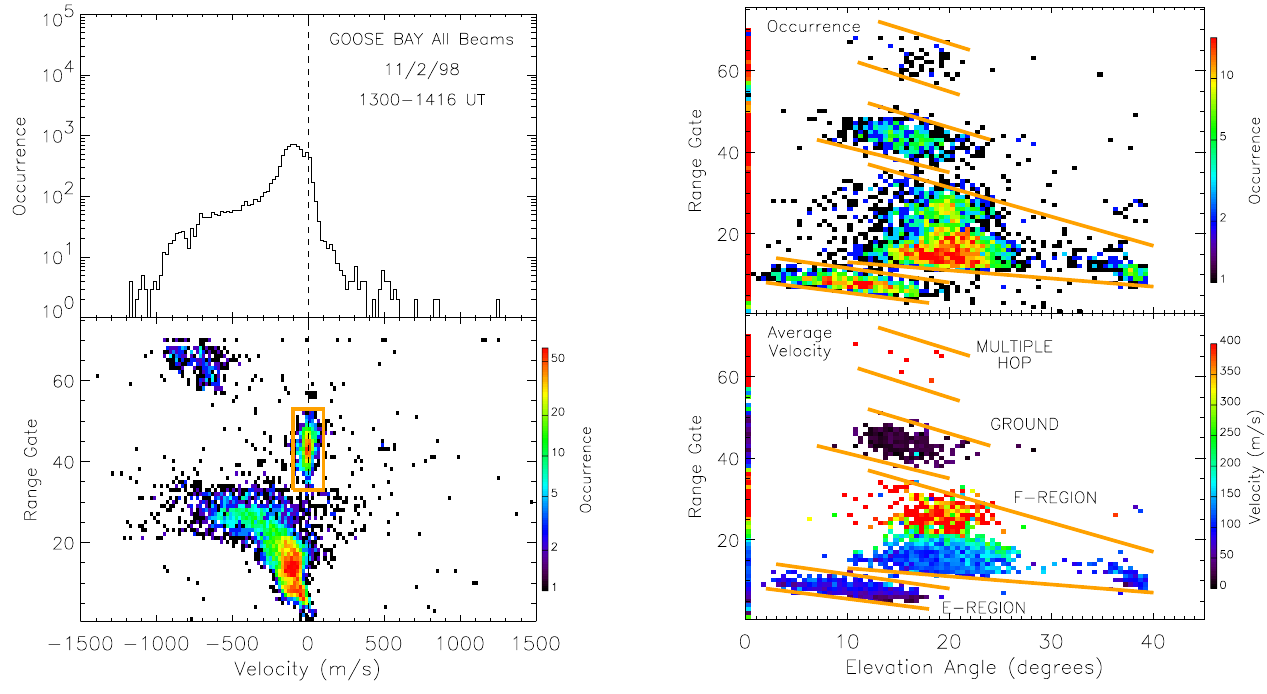
Fig. 6. (a) Line-of-sight velocity distribution from all beams of the Goose Bay radar for the interval 13:00–14:16UT on 11 February 1998, as well as the distribution in range gate-velocity space. The orange rectangle represents the extent of the velocity-range gate filter applied to these data to remove contaminating ground backscatter. (b) Occurrence distribution for the same interval in range gate-elevation angle space, as well as the average line-of-sight velocity measured in each distribution cell.